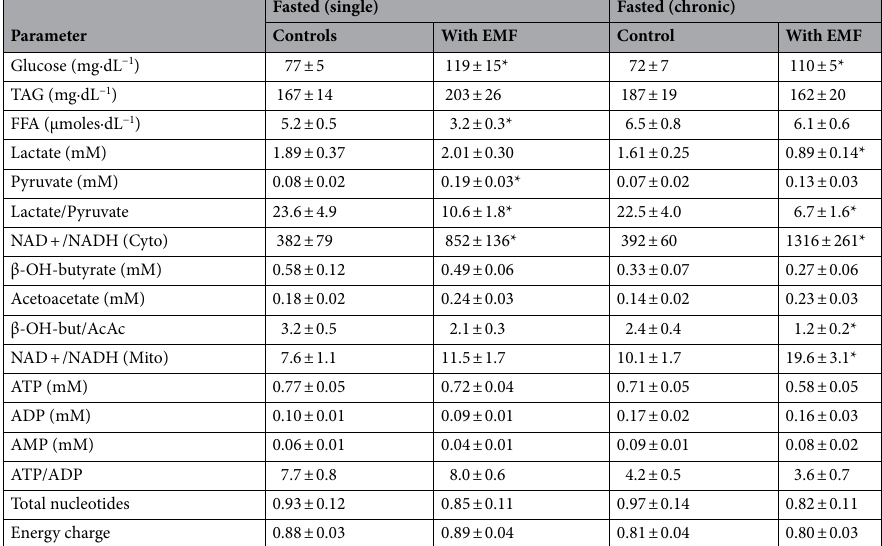
Table 1. Effects of chronic exposure to EMFs on rat blood glucose, lipids, and parameters indicative of redox state and energy status. Results are the mean ± SE of four individual observations per experimental group, which consisted of rats exposed to 60-Hz EMFs during 15 min/day for 14 consecutive days before the single (acute) exposure at the day of the experiment (8 control animals vs. 8 treated rats), and blood samples were taken 30 min after ending exposure. Abbreviations: β-OH-but, β-hydroxybutyrate, AcAc, acetoacetate, Cyto, cytoplasm, and Mito, mitochondria. Statistical significance: * p < 0.01 versus control